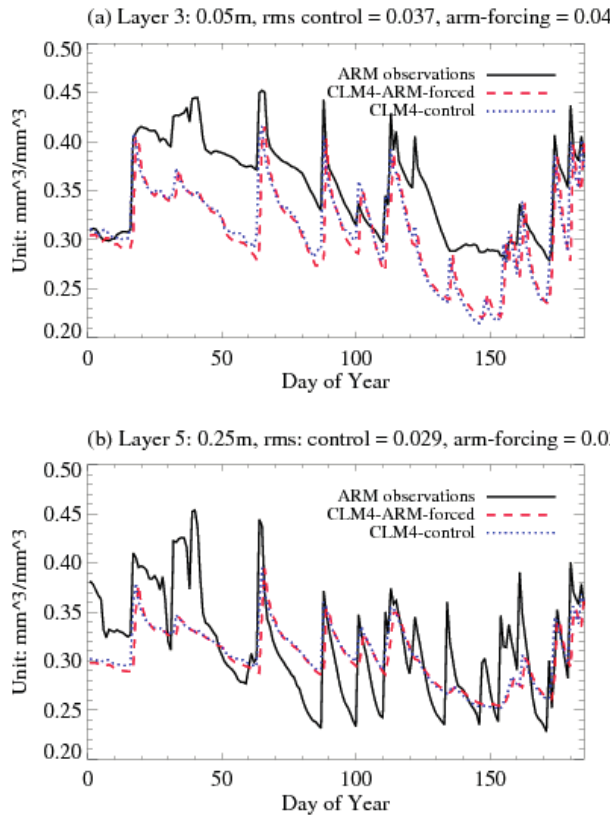
Figure 6. Simulated daily averaged volumetric soil moisture from offline community land model (CLM4) in ( a ) the upper layer (layer 3, − 0.05 m) and ( b ) the lower layer (Layer 5, − 0.3 m). The control run (CLM4-control) is forced by the default atmospheric forcing provided by National Center for Atmospheric Research (NCAR) model release package and the ARM-forced run (CLM-ARM-forced) uses the hourly ARM observed atmospheic forcing data in Year